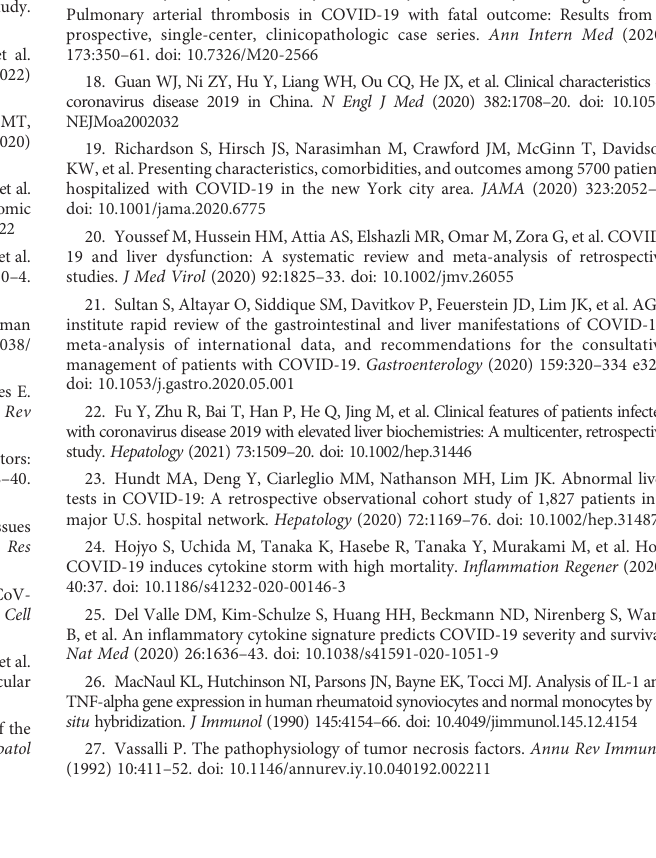
Cohort characteristics of TNFA high and TNFA low groups in the blood and the intestine. (A) Cohort characteristics of patients with low (below the median) systemic expression of TNFA (n=22, black), and high (above the median) systemic expression of TNFA (n=22, red) in the blood are depicted. (B) Cohort characteristics of patients with low (below the median) intestinal expression of TNFA (n=22, black), and high (above the median) intestinal expression of TNFA (n=23, yellow) in the intestine are depicted.